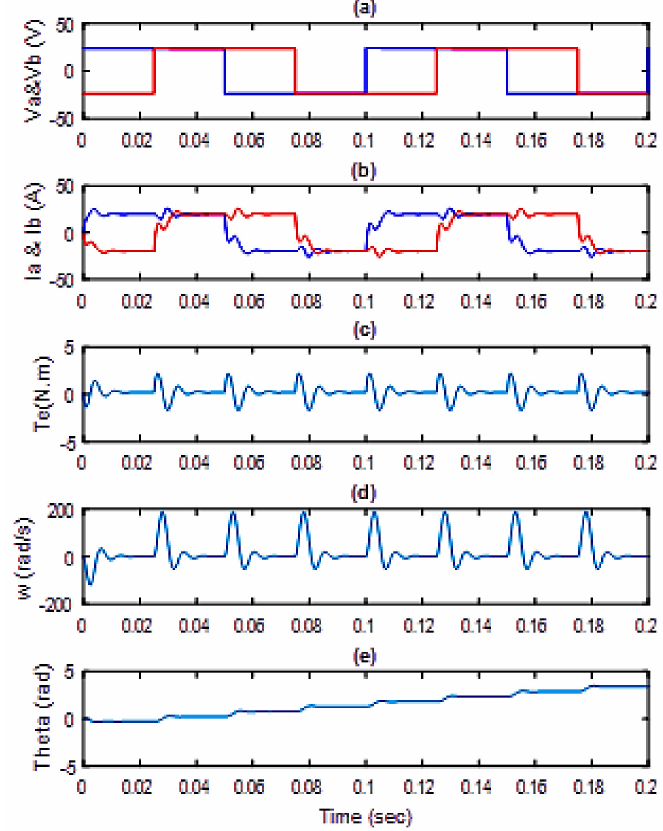
Figure 7. Results of proposed model at T L = 0.2 Nm and period of time 0.1 s: ( a ) Va (blue) Vb (red),